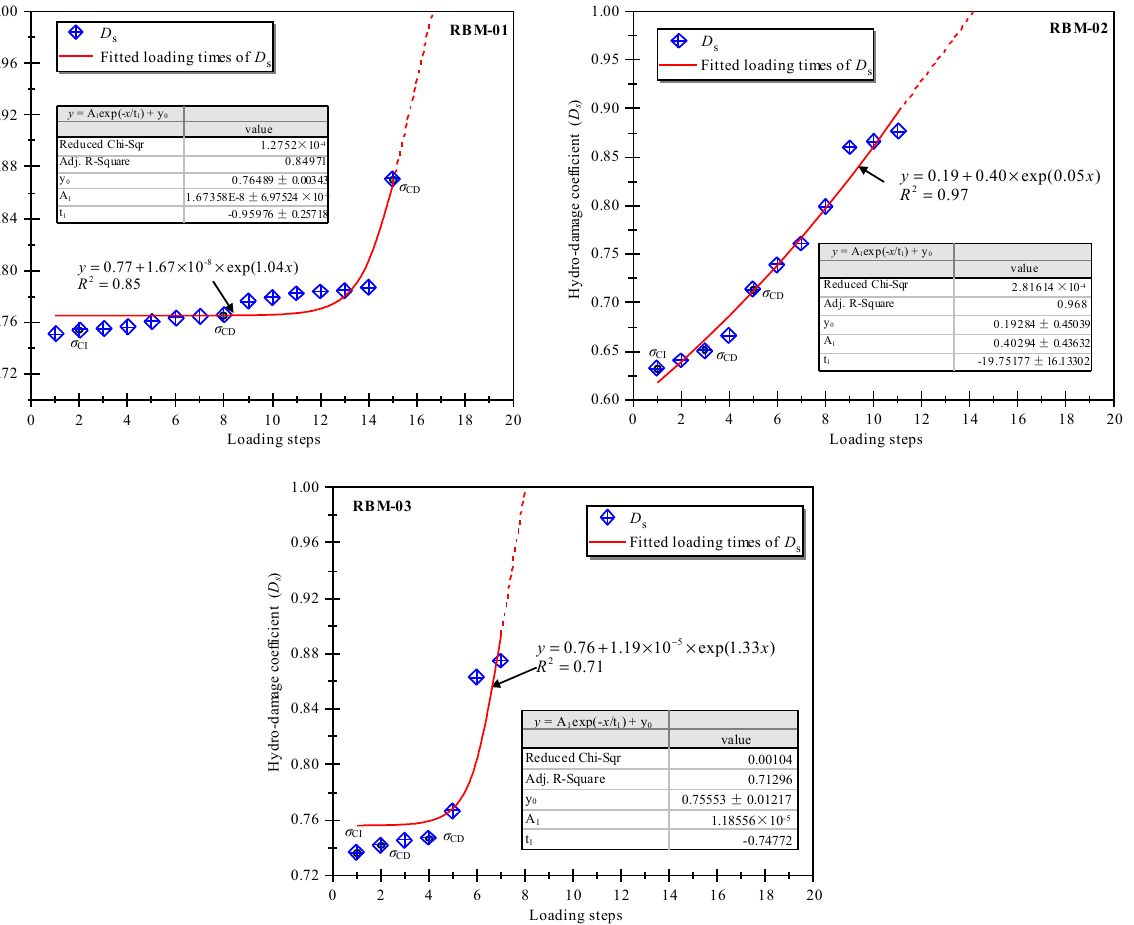
Figure 8. Change law of the hydro-damage coefficient during mudstone specimen failure.